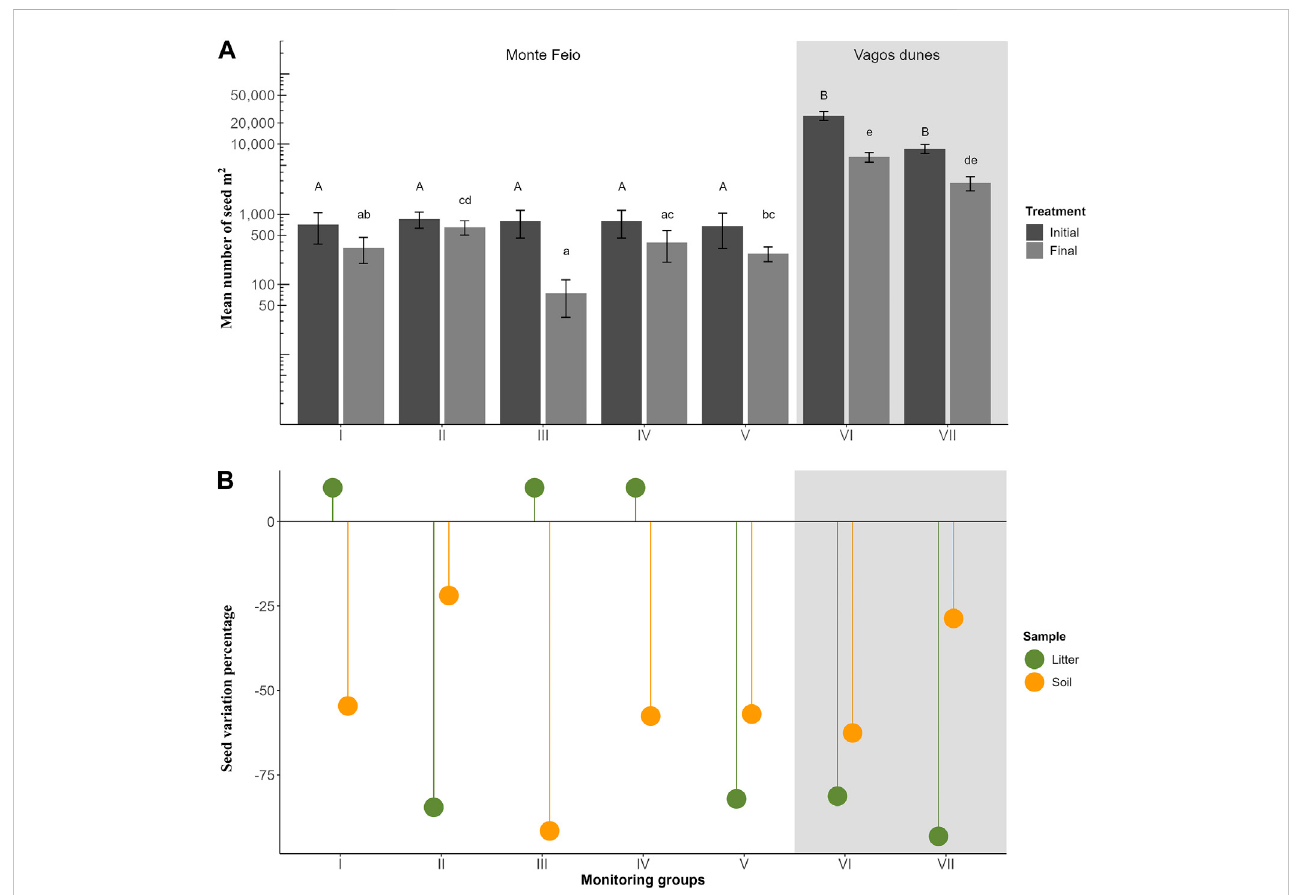
FIGURE 5 Density of Acacia longifolia seed bank on different monitoring groups. (A) Mean number of seeds per m 2 ± SE ( n = 36) before and right after the initial control treatments (Initial) and after the fi nal follow-up treatments (Final) are represented on a logarithmic scale. Letters show the results of Tukey post-hoc test. (B) Variation in the number of seeds of A. longifolia in litter or soil layers is represented as